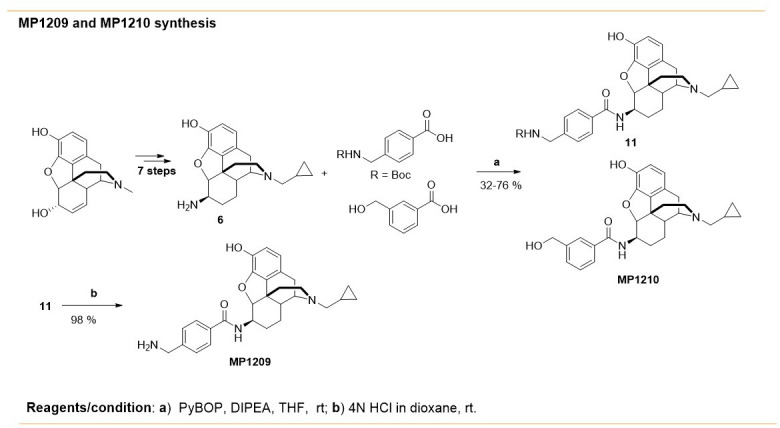
Synthesis of m-arylamido dihydromorphinans MP1210 and p-arylamido dihydromorphinan analog, MP1209.